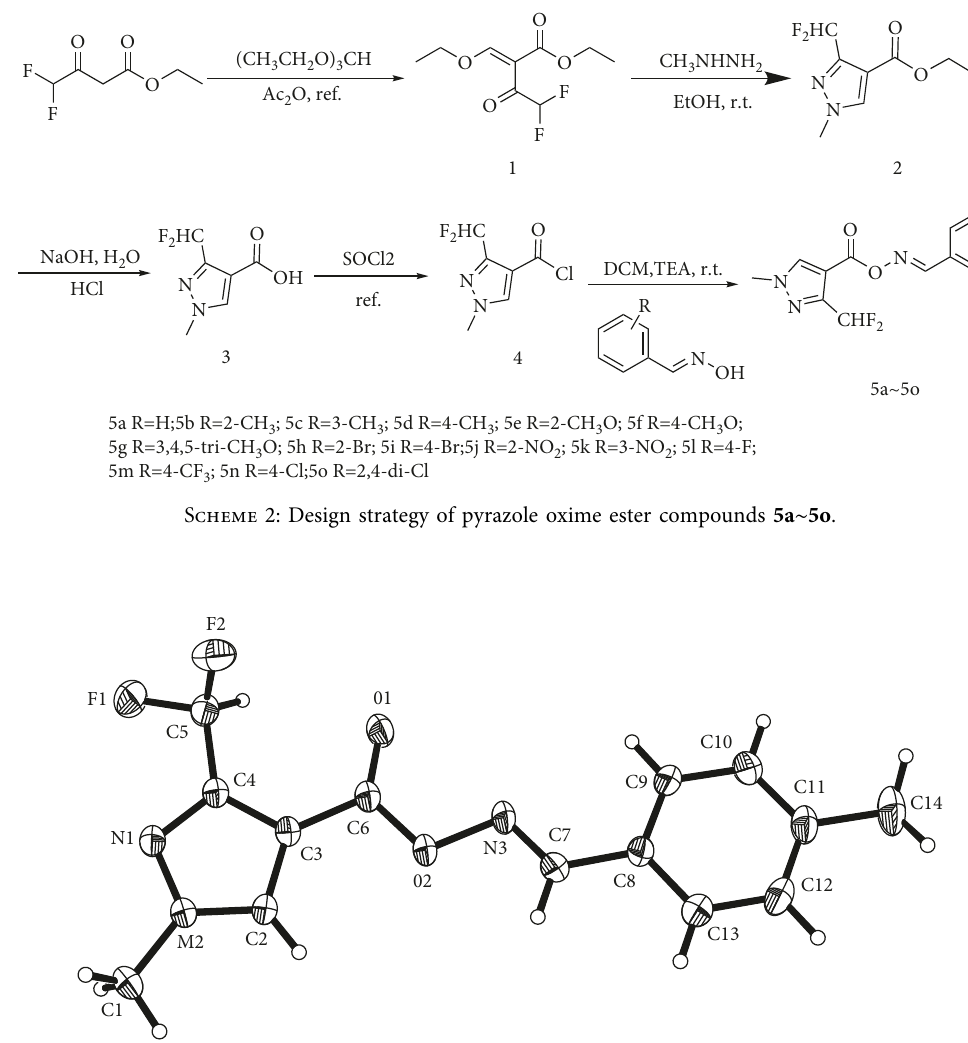
Figure 2: Molecular structure of ( E )-4-methylbenzaldehyde ( O )-(3-(difluoromethyl)-1-methyl-1 ( H )-pyrazole-4-carbonyl)